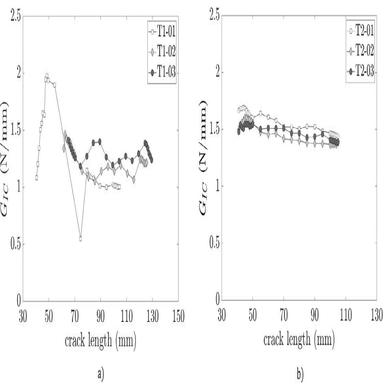
R-curves for (a) rigid adhesive samples and (b) flexible adhesive samples.